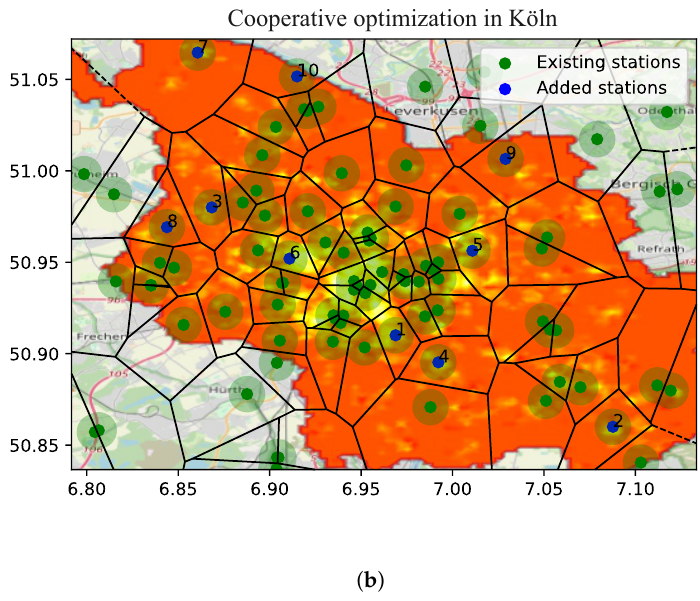
Figure 6. Existing and new CS in the city of Cologne (“Köln”) as decided by the cooperating ( a ) and competing ( b ) optimization strategy. Green dots are existing CS, and blue dots are new CS. The order of stations added is indicated with numbers at each blue dot. The shaded area surrounding each station shows the area in which each station is able to collect the attractiveness. The underlying heat map is plotted only for the city and district of Cologne, where yellow indicates a high attractiveness and red a comparatively low attractiveness.